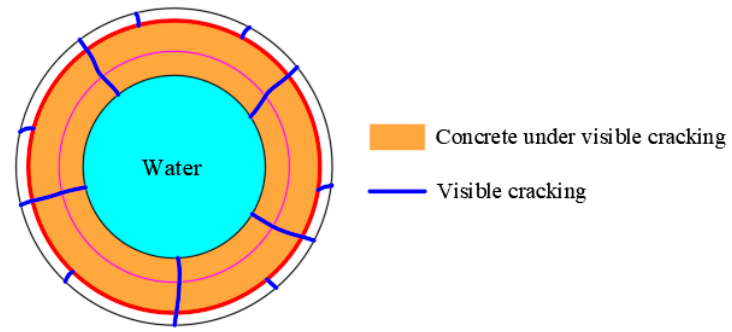
Figure 18. Visible cracking stage.